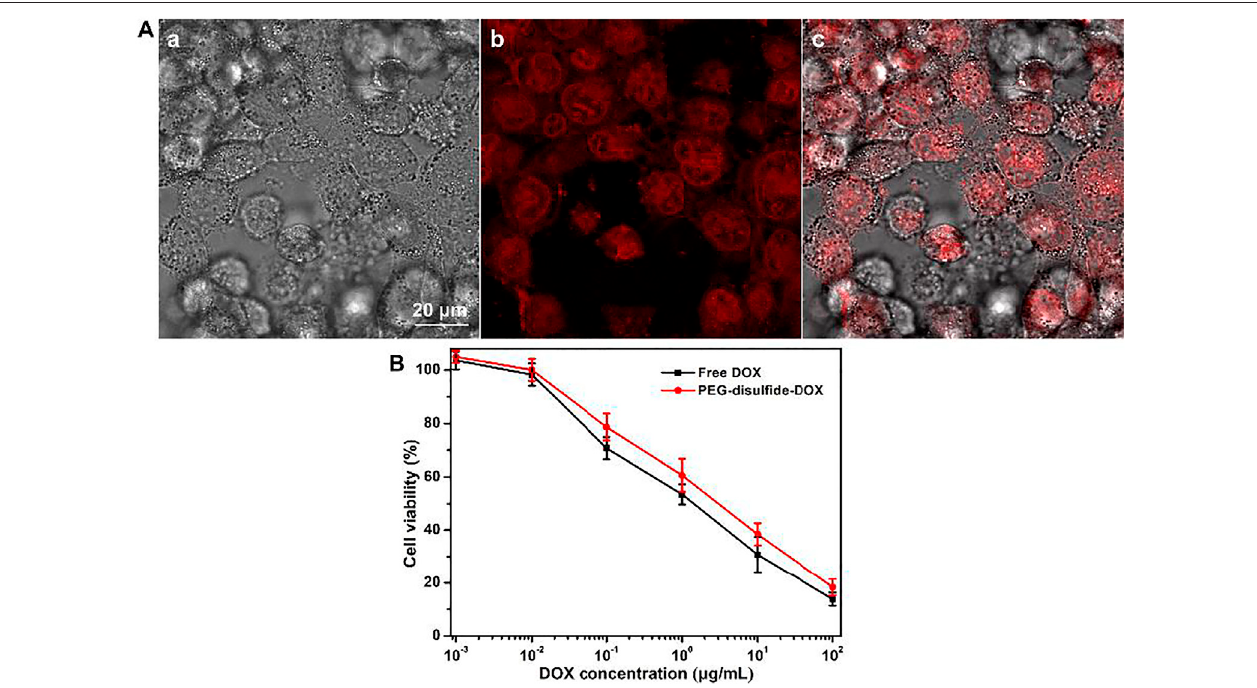
FIGURE 5 | (A) CLSM of MCF-7 cells after incubation with PEG – disul fi de – DOX micelles for 2 h; a: bright fi eld image, b: red fl uorescence image, and c: overlap of bright fi eld and fl uorescence images. (B) Cytotoxicity of MCF-7 cells following 24-h incubation with PEG – disul fi de – DOX and free drugs as a function of DOX dosages. The data are presented as the average ± standard deviation ( n (cid:1)